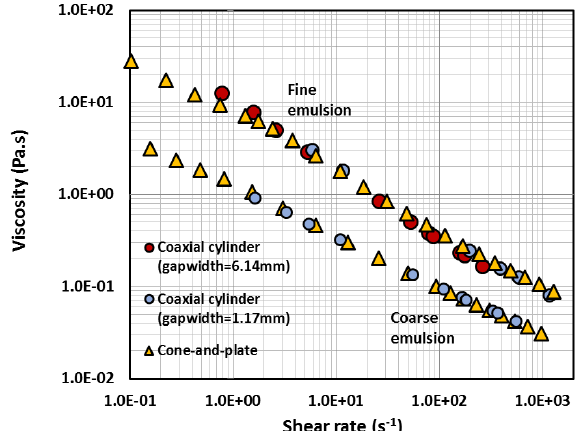
Figure 6. Comparison of viscosity data of fine and coarse emulsions obtained from different instruments.